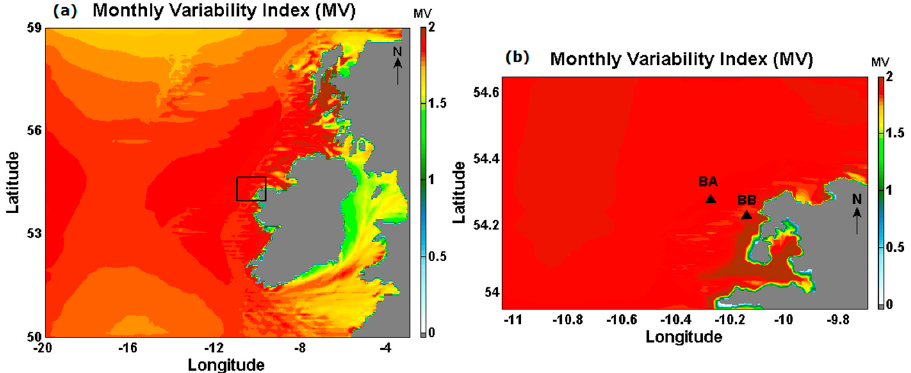
Figure 27. 12-year monthly variability index ( MV ) values for ( a ) CI and ( b ) AMETS model domains.